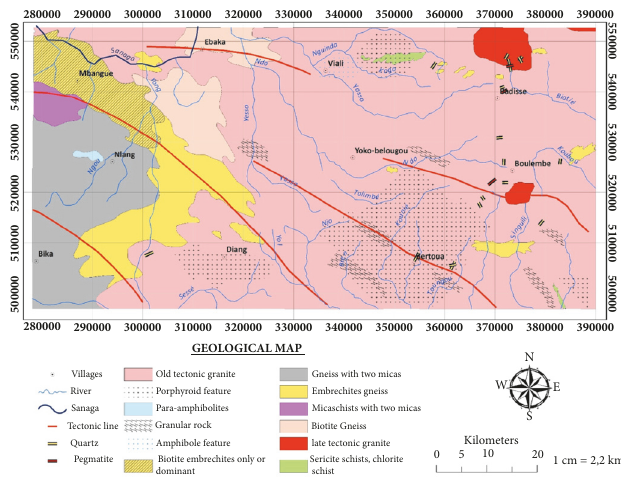
Figure 2: The geological map of the area of study (modified from [28,